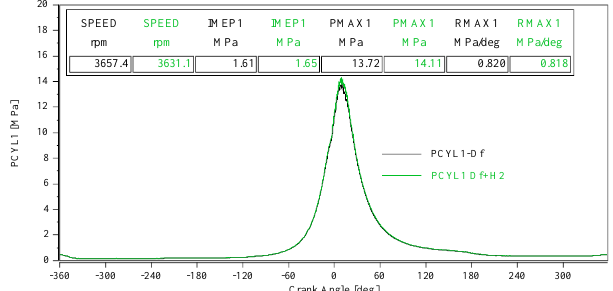
Fig. 9. Pressure inside the combustion chamber at engine speed about 2000 Fig. 13. Internal combustion chamber pressure during vehicle acceleration rpm – gear 4, at diesel fuel supply (black colour) and diesel oil and H for second gear at engine speed 3657 rpm, for diesel (black colour) and (green colour), additionally the table shows average indexed pressure diesel and H (green colour), in addition the table shows the average indica- (IMEP1), maximum combustion pressure (PMAX1), maximum pressure tor pressure (IMEP1), maximum combustion pressure (PMAX1), maxi- rise speed (RMAX1) and engine speed (SPEED) mum pressure rise speed (RMAX1) and engine speed (SPEED)